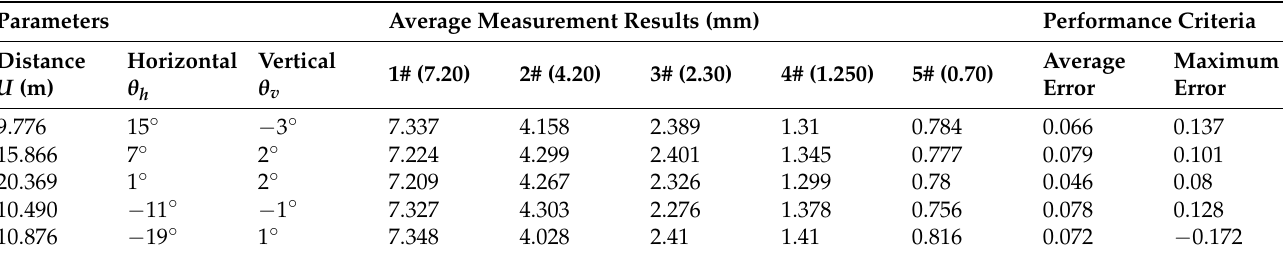
Table 4. Measurements results of five artificial